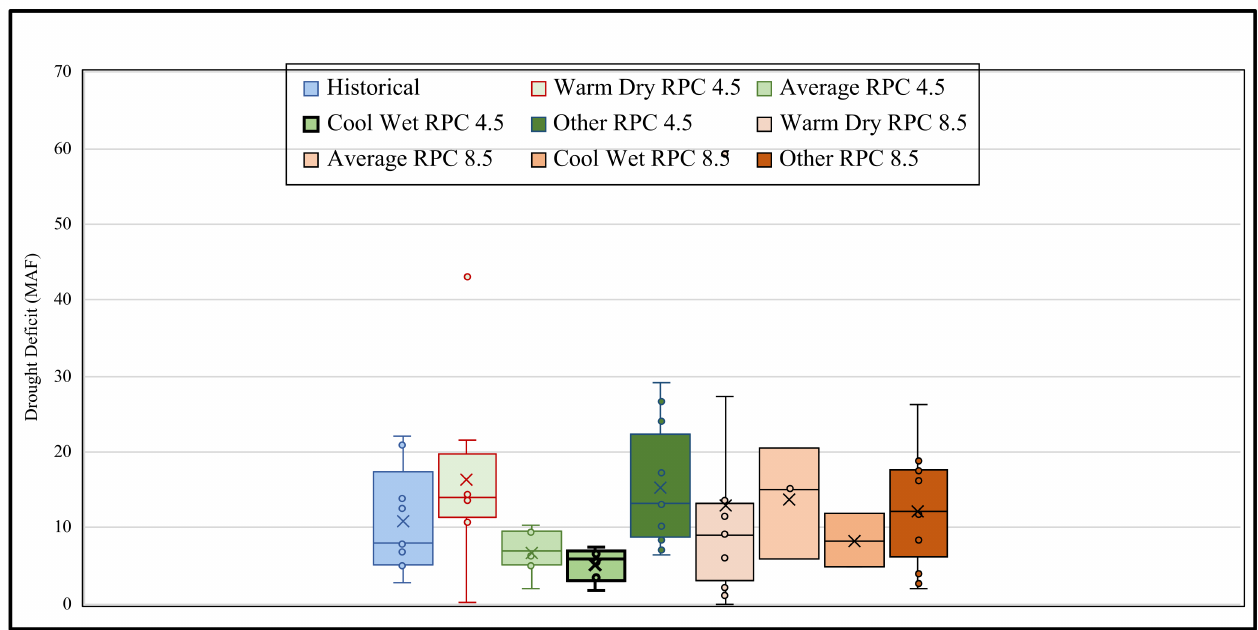
Figure 4. Box plot of Yuba River’s drought deficit quantities historical (1950–2015) under all projected models (2020–2099). Bottom bar and top bars extended from the box represent the lowest and highest usable values. The line in the middle represents the median value in the data. Bottom half of the box represents the lower quartile, and the top half represents the upper quartile. The highlighted boxes are significant ( p = 0.05) in terms of different from the historical distribution based on the t -test. (Note: 1 MAF = 1233 million cubic meters).